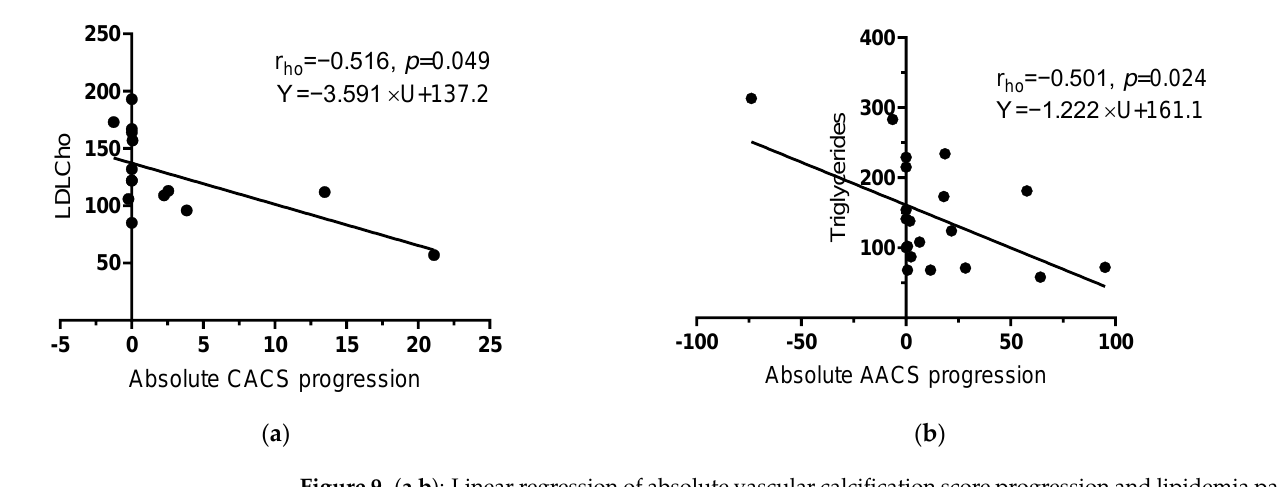
Figure 9. ( a – b ): Linear regression of absolute vascular calcification score progression and lipidemia parameters.